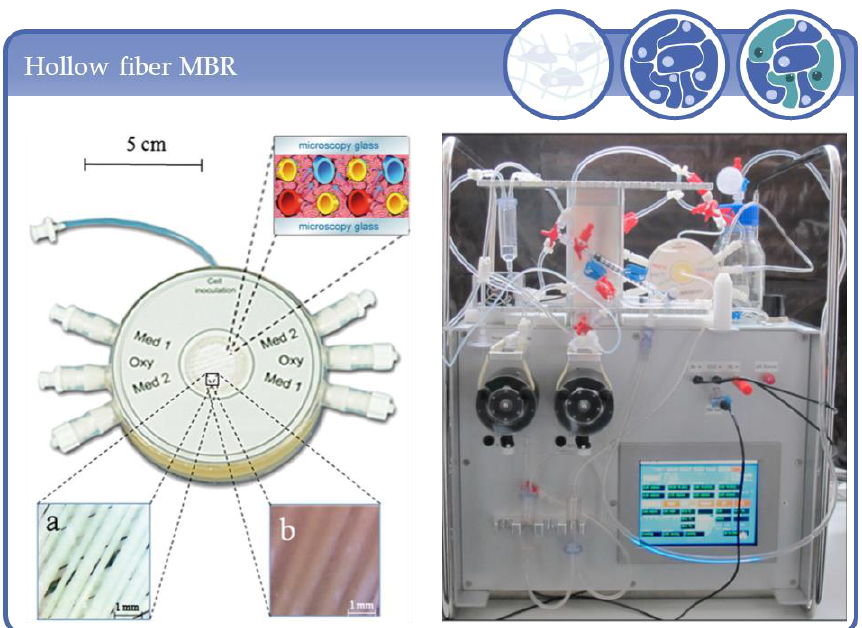
Figure 10. Micro-hollow fiber bioreactor for high-density liver cell culture. Media capillaries in red and blue and oxygenation capillaries in yellow. The lower inserts show microscopic pictures (30-fold magnification) of the capillary bed before inoculation ( a ) and immediately after cell inoculation, revealing a homogenous distribution of the inoculated cell suspension between the capillaries ( b ). Right: Bioreactor operation in an electronically controlled perfusion device equipped with pumps for medium recirculation and medium feed, temperature control and with a valve-regulated gas mixing unit. Perfusion parameters are automatically monitored and can be regulated via an integrated touch screen Reprinted from [104] with permission of John Wiley and Sons.